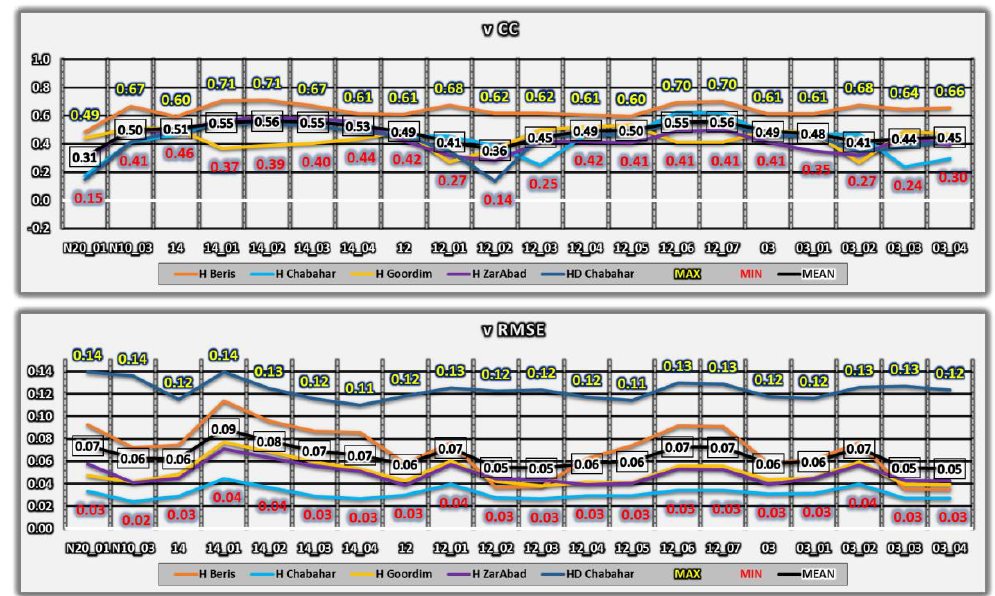
Figure 8. Correlation coefficient and RMSE of surface v-velocity component for model results and